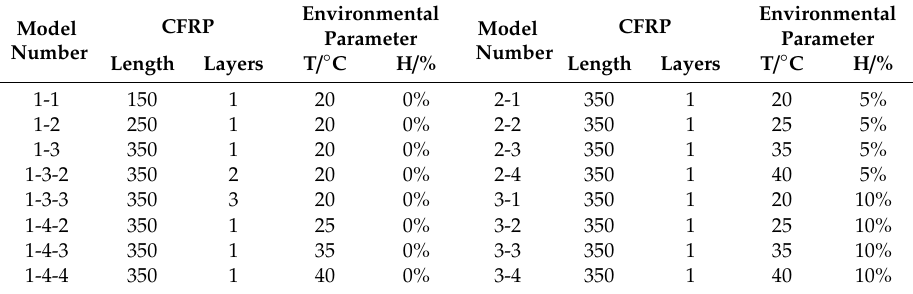
Table 2. Slip testing parameters of CFRP-reinforced arch concrete